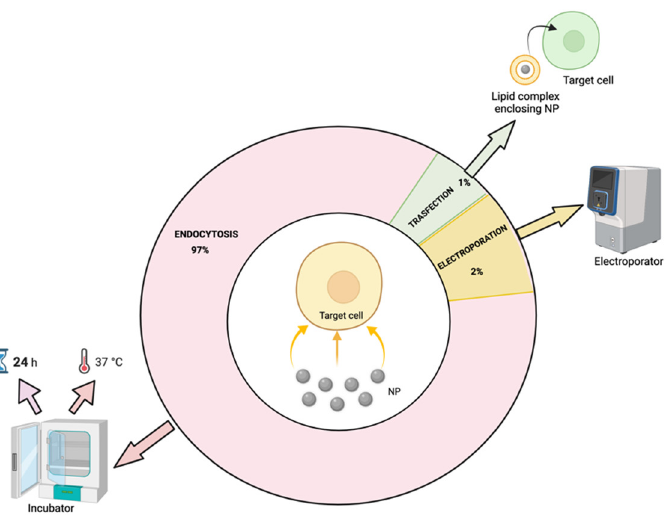
Figure 6. NP uptake mechanisms and strategies. Figure created with BioRender. Available online: https://biorender.com/ (accessed on 25 March 2022).